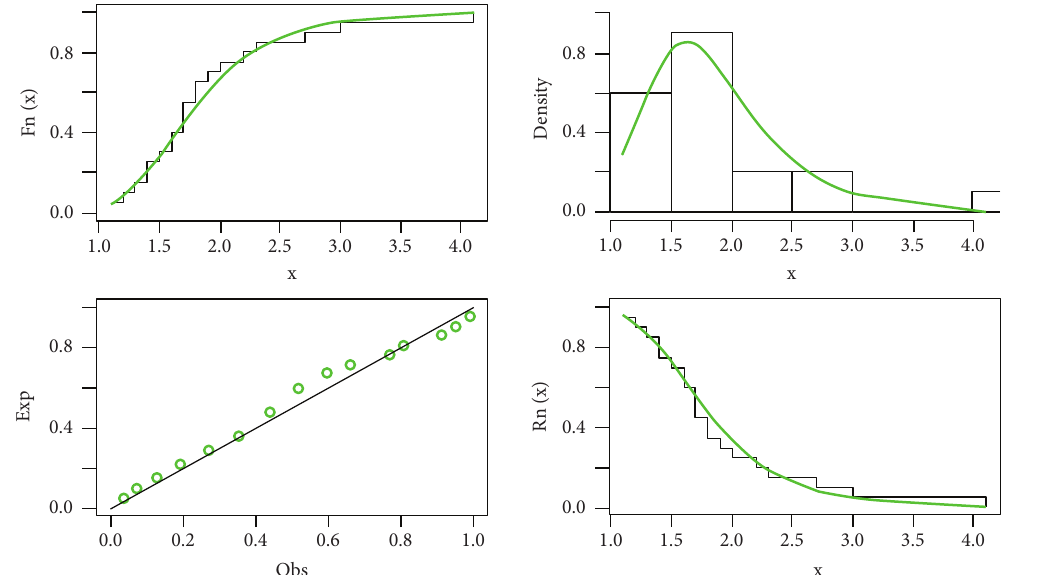
Figure 3: Fitted cdf, pdf, and pp plots for dataset